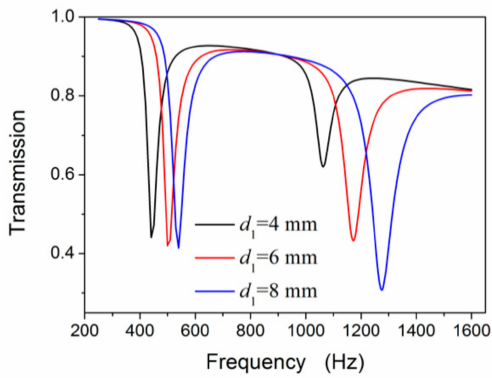
Figure 7. The transmission curves of NSHS-AMM with di ff erent diameters of the external split hole.